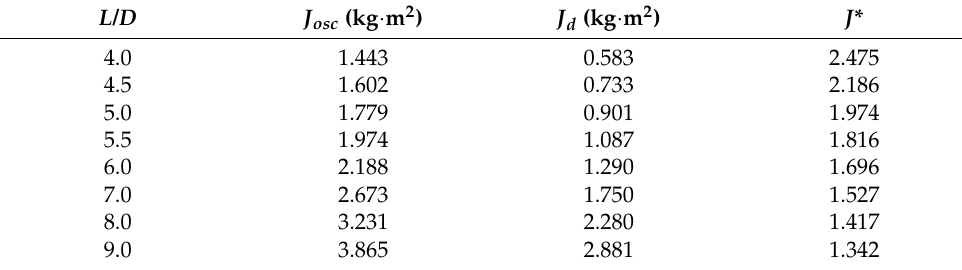
Table 2. The parametric details of the experiments in this study.